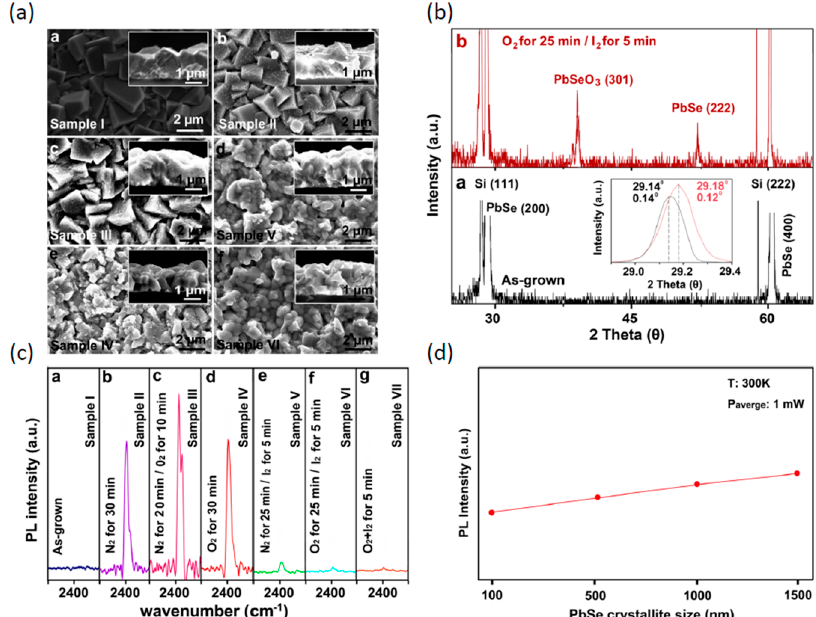
Figure 6. The ( a ) morphological, ( b ) structural, and ( c ) photoluminescence (PL) optical properties of PbSe polycrystalline coatings fabricated by annealing in single or hybrid atmosphere, and ( d ) the PL intensity as a function of crystallite size. Reprinted with permission from [75]. Copyright AIP 2013.